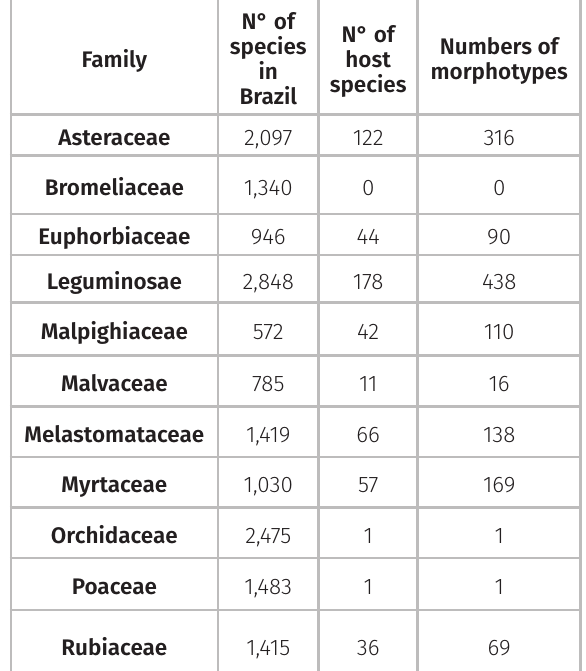
Table V. Richness of galls associated with the principal angiosperm families in